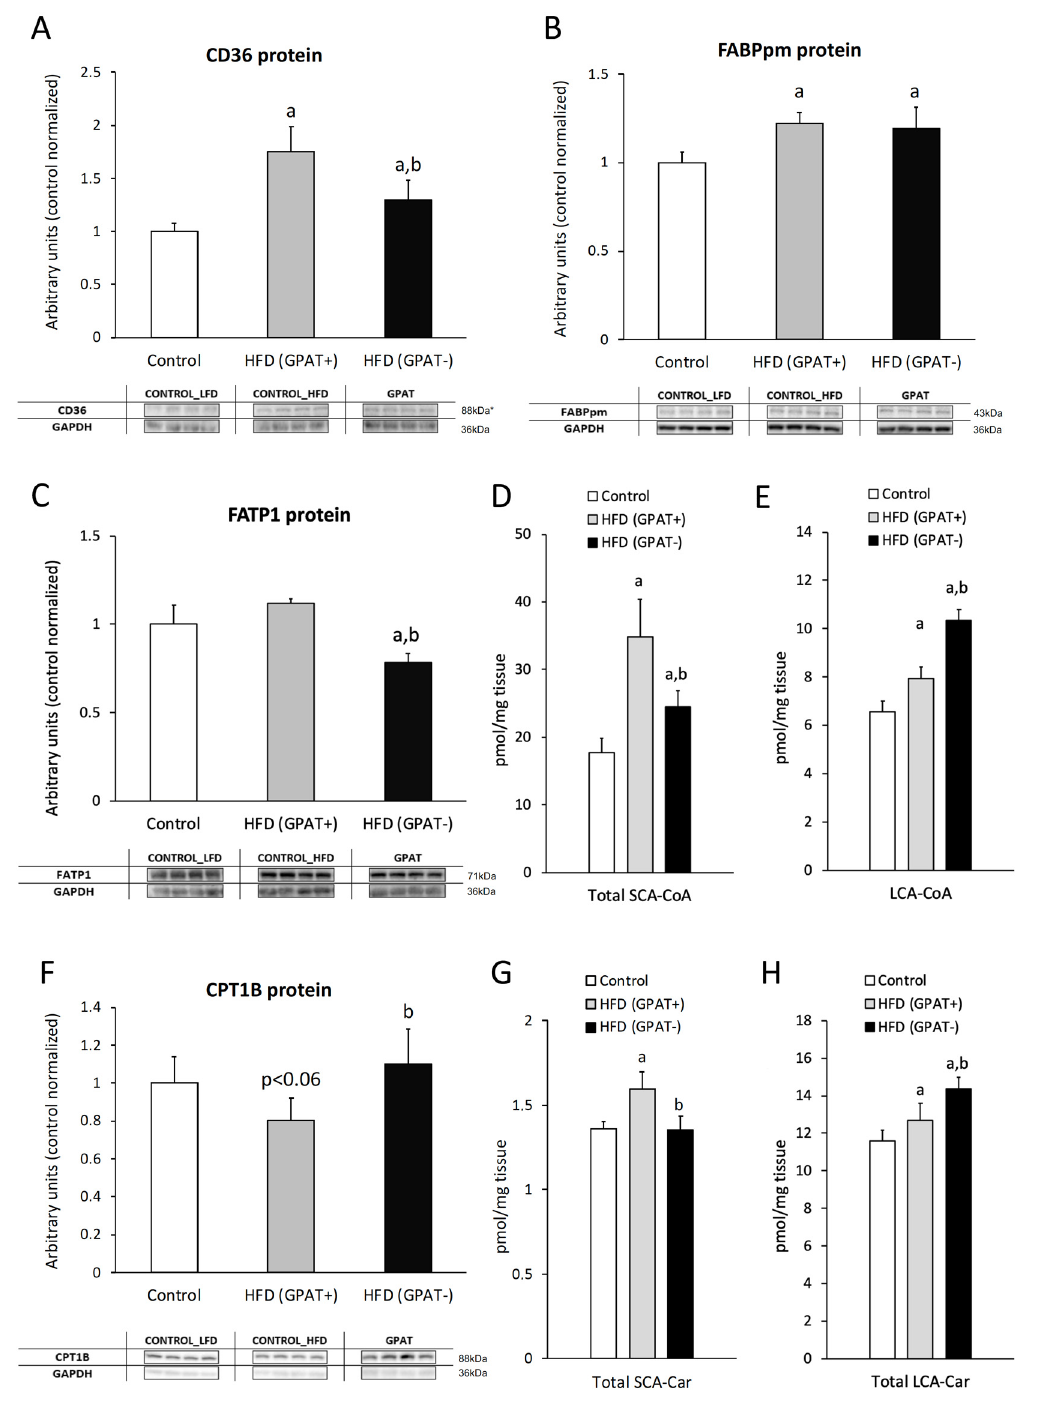
Figure 2. The impact of skeletal muscle GPAT silencing on the protein expression of fatty acid transporters, the content of acyl-CoA’s and acyl-carnitines in gastrocnemious muscle of high-fat diet mice. Panel A —protein expression of CD36; Panel B —protein expression of FABPpm; Panel C —protein expression of FATP1; Panel D and E —the content of short-chain acyl-CoA and long-chain acyl-CoA, respectively. Panel F —protein expression of CPT1B; Panel G and H —the content of short-chain and long-chain acyl-carnitines, respectively. Values are mean ± SD ( n = 8 per group); a— p < 0.05 vs. control; b— p < 0.05 vs. HFD (GPAT + ) ; significance by ANOVA; HFD—high-fat diet. * The observed molecular weight of indicated proteins is di ff erent to the theoretical one, as stated by the antibody manufacturer.